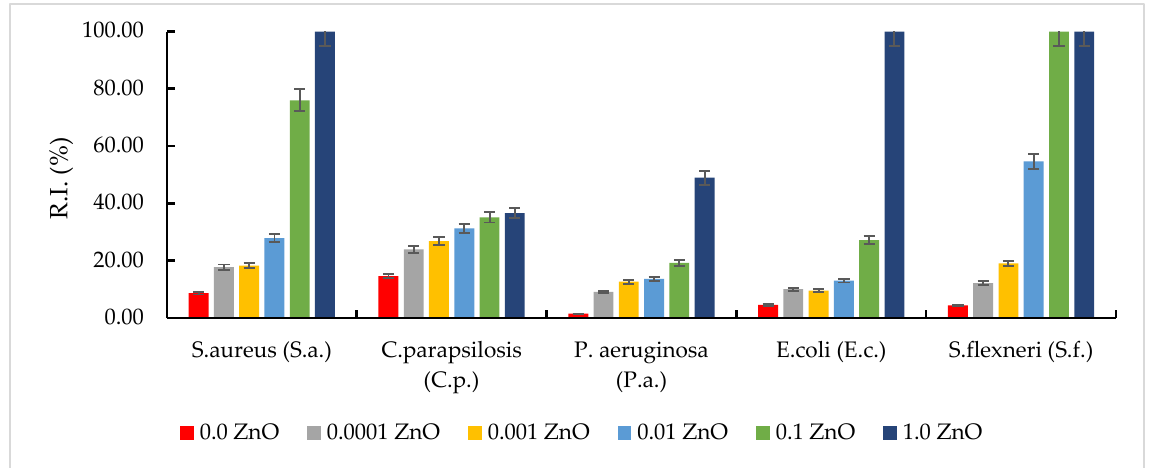
Figure 9. Microbial inhibition rate at various ZnO quantities.